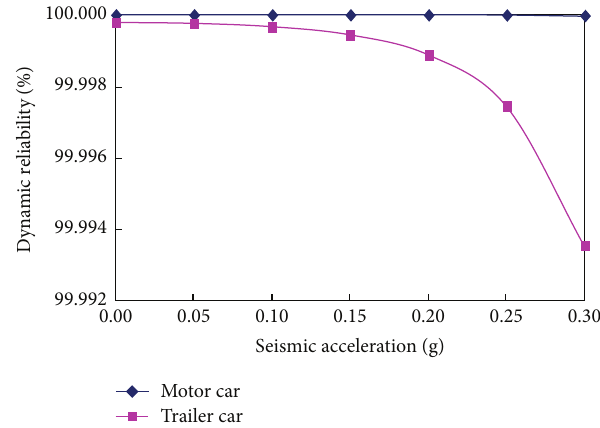
Figure 15: Dynamic reliability for carbody vertical acceleration with respect to seismic acceleration.